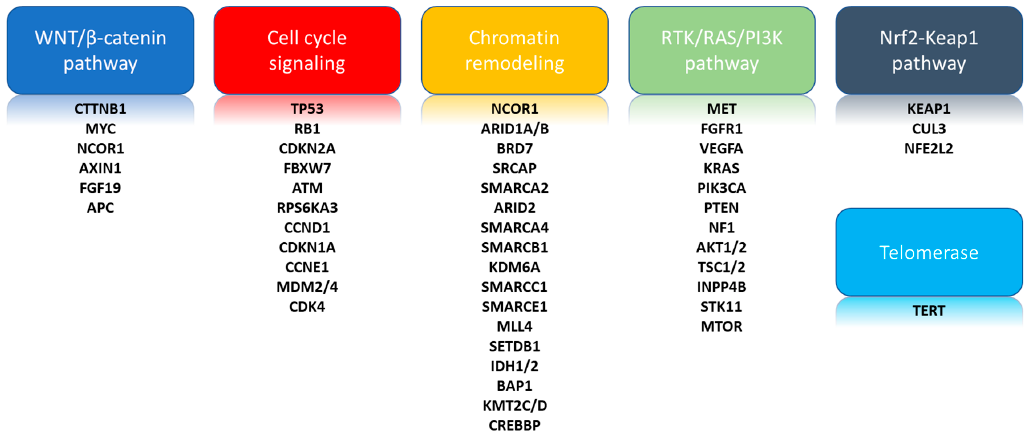
Figure 1. Major gene mutations and pathways altered in hepatocellular